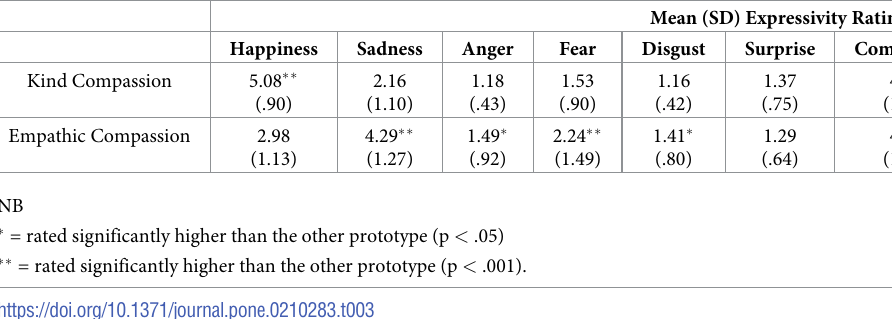
Table 3. Mean (SD) of emotions associated with kind and empathic compassion